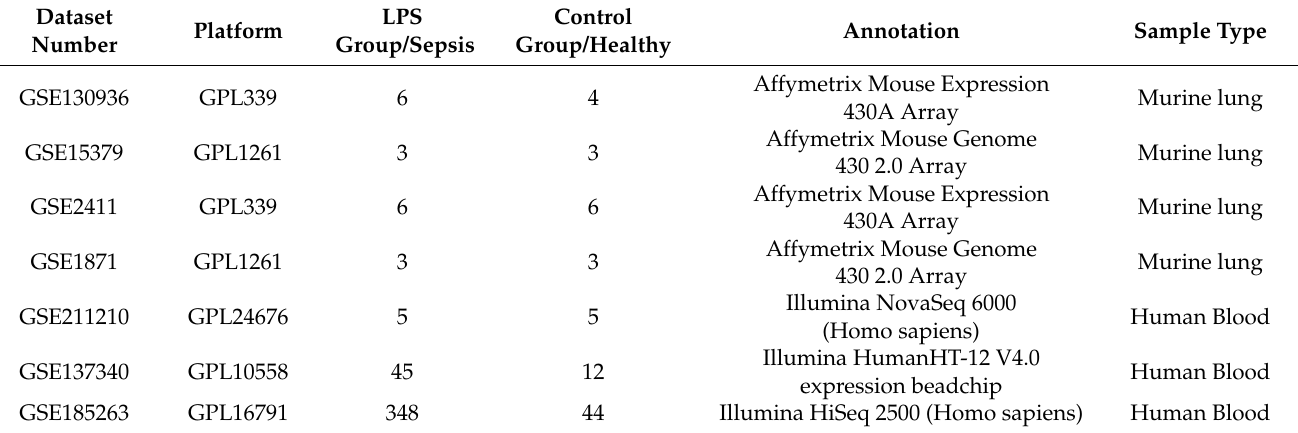
Table 2. The information of GEO